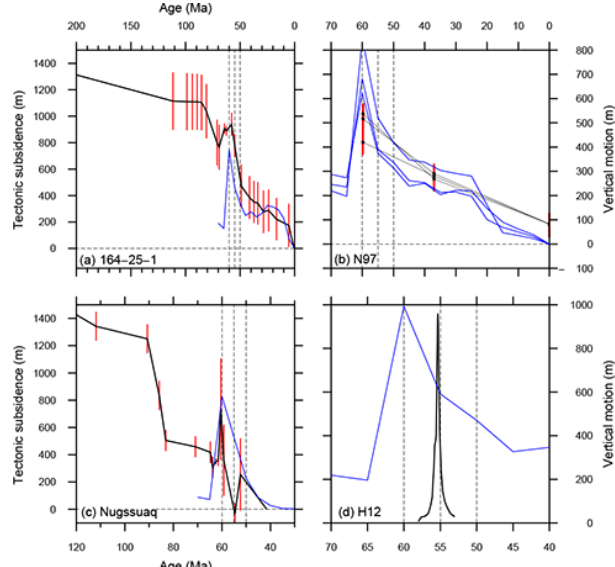
Figure 10. (a) Backstripped water-loaded tectonic subsidence histo- ries for a well in the southern Faroe–Shetland Basin (location given in Fig. 4; Clift and Turner, 1998). (b) Evolution of decaying up- lift calculated from modelled stratigraphic sections across the North Sea reproduced from Nadin et al. (1997). Given the long wave- length nature of the model dynamic topography and the relatively close proximity of the three stratigraphic sections (Fig. 6; stars), we include all three results in this plot. Red error bars represent un- certainty in uplift decay over time. The blue curve on each plot is the corresponding time-dependent evolution of dynamic topography (Sect. 2) for each site (Fig. 4). (c) Backstripped water-loaded tec- tonic subsidence histories for Nugssuaq along the western Green- land margin (Fig. 6) from Clift et al. (1998). Blue dynamic topogra- phy curve through time derived as described in Fig. 7. (d) Modelled uplift history from Hartley et al. (2012) – see main text for descrip-